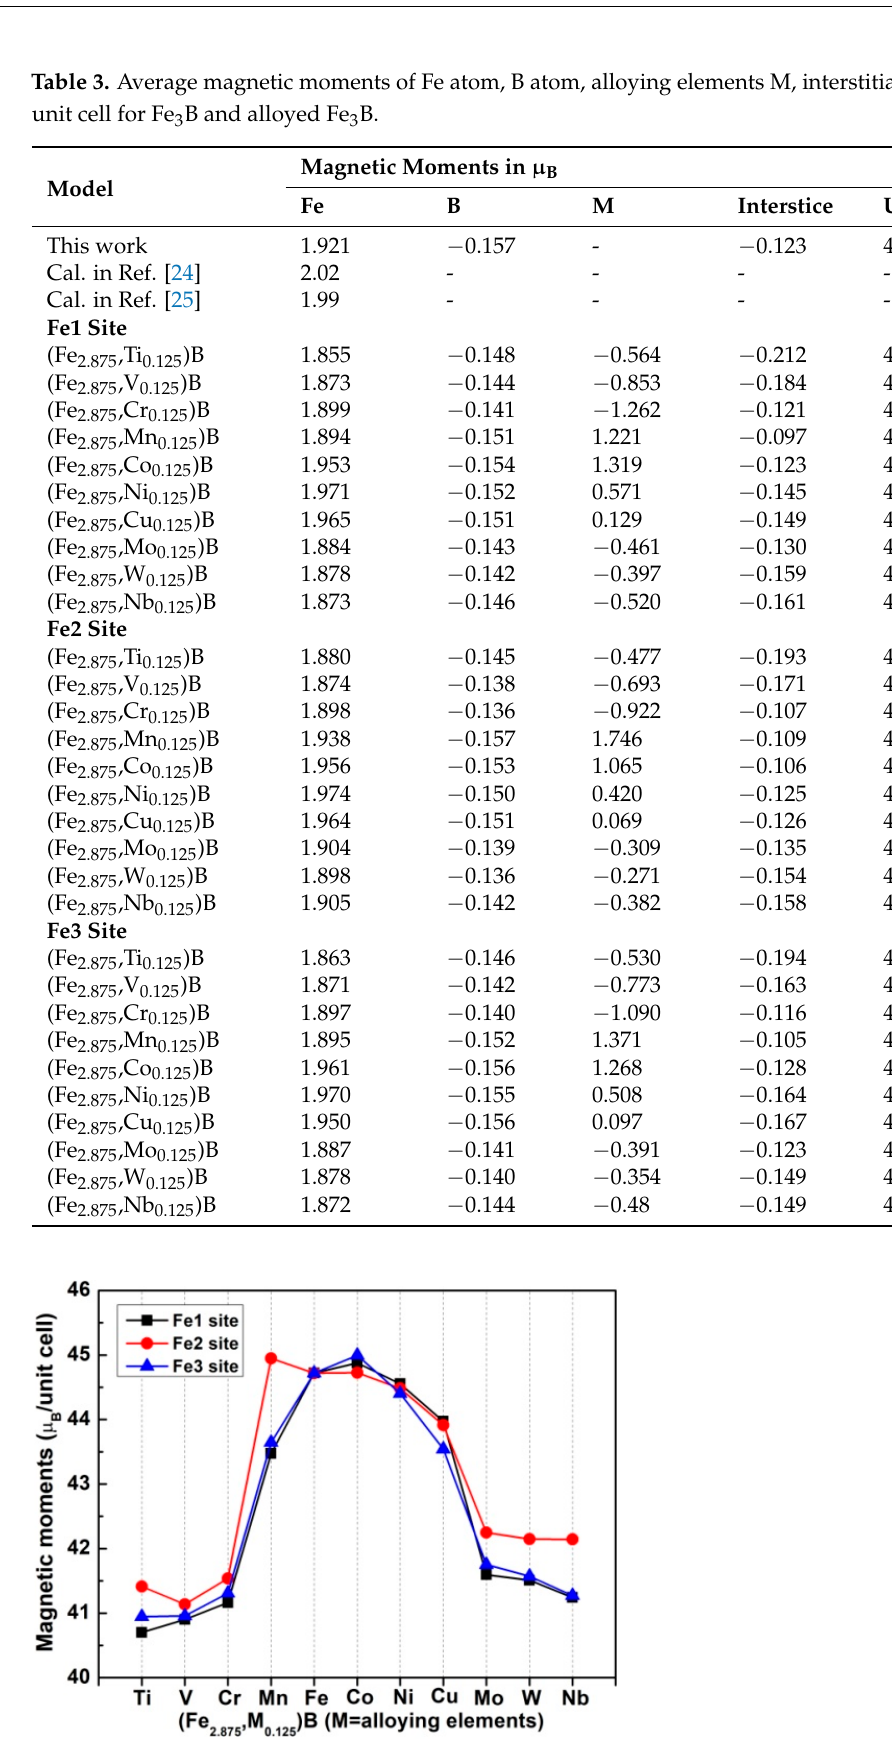
Figure 7. Magnetic moments of unit cells for Fe 3 B and alloyed Fe 3 B.